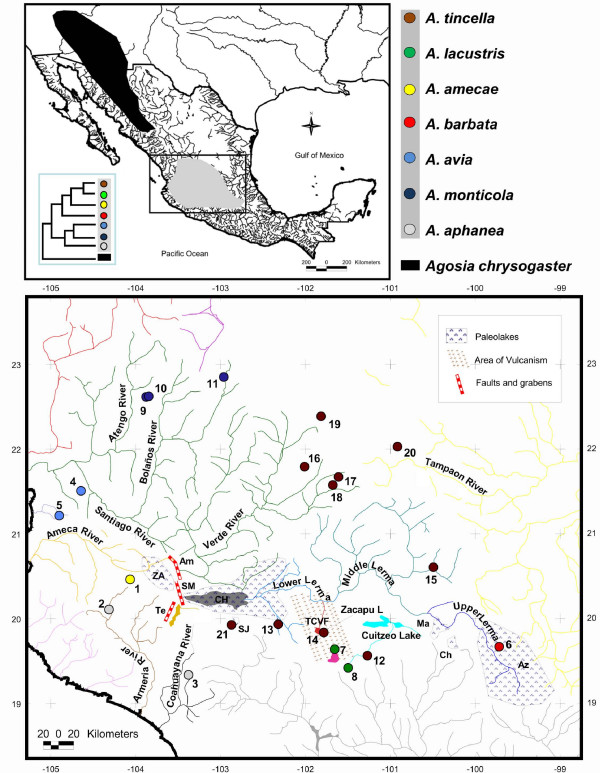
Localities, cladogenetic, and geologic events in the evolutionary and biogeographic history of Algansea. Paleolakes: Az = Aztlan; CH = Chapala (Gray area inside the paleolake indicates the current Chapala lake extension); Ch = Chincua; Ma = Maravatio; Za = Zacoalco. Faults and grabens: Am = Ameca; SM = San Marcos. TCVF = Tarascan Corridor Volcanic Field; SJ = San Juanico lake.